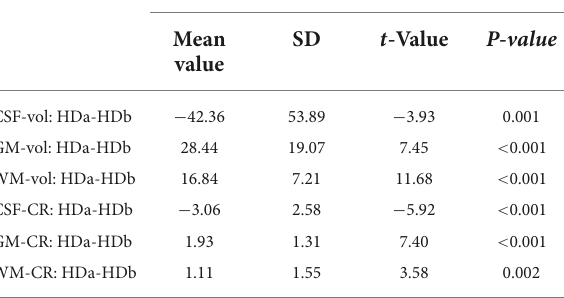
Paired differences P-value